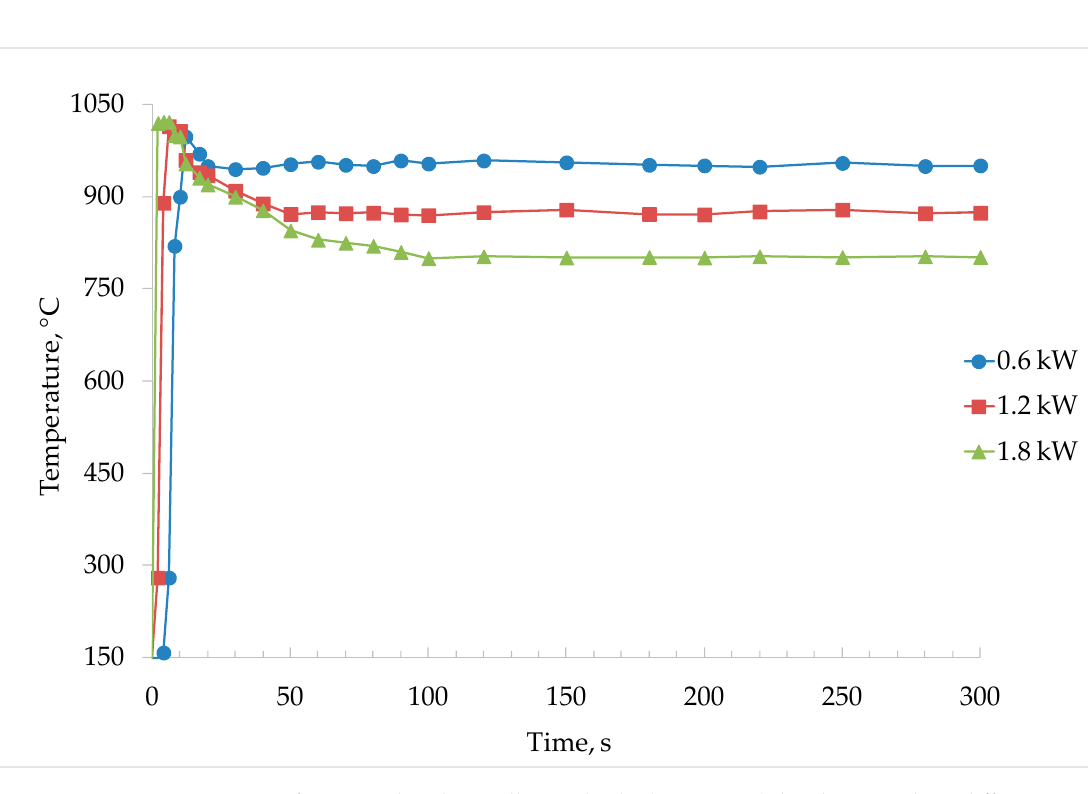
Figure 5. Heating rates of BR mixed with metallurgical coke (C/BR 0.180), by choosing three different power capacities, 0.6 kW, 1.2 kW and 1.8 kW at 1 L/min N 2 flow constant for 5 min.